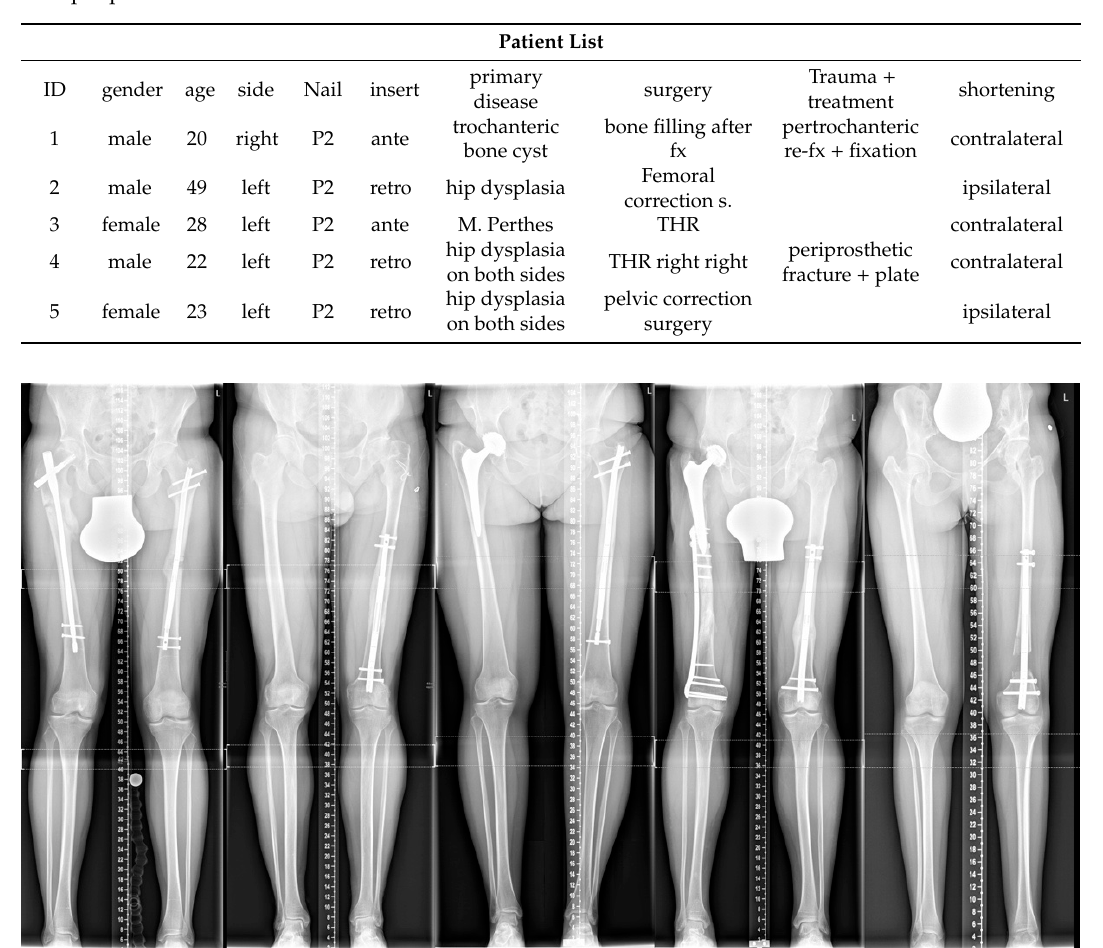
Table 2. Patient list presenting patient characteristics, primary disease, previous surgery, and treatment. Table 1. Demographic data and baseline characteristics. Ante: antegrade insertion; retro: retrograde insertion; fx: fracture, re-fx: refracture; THR: total hip replacement.